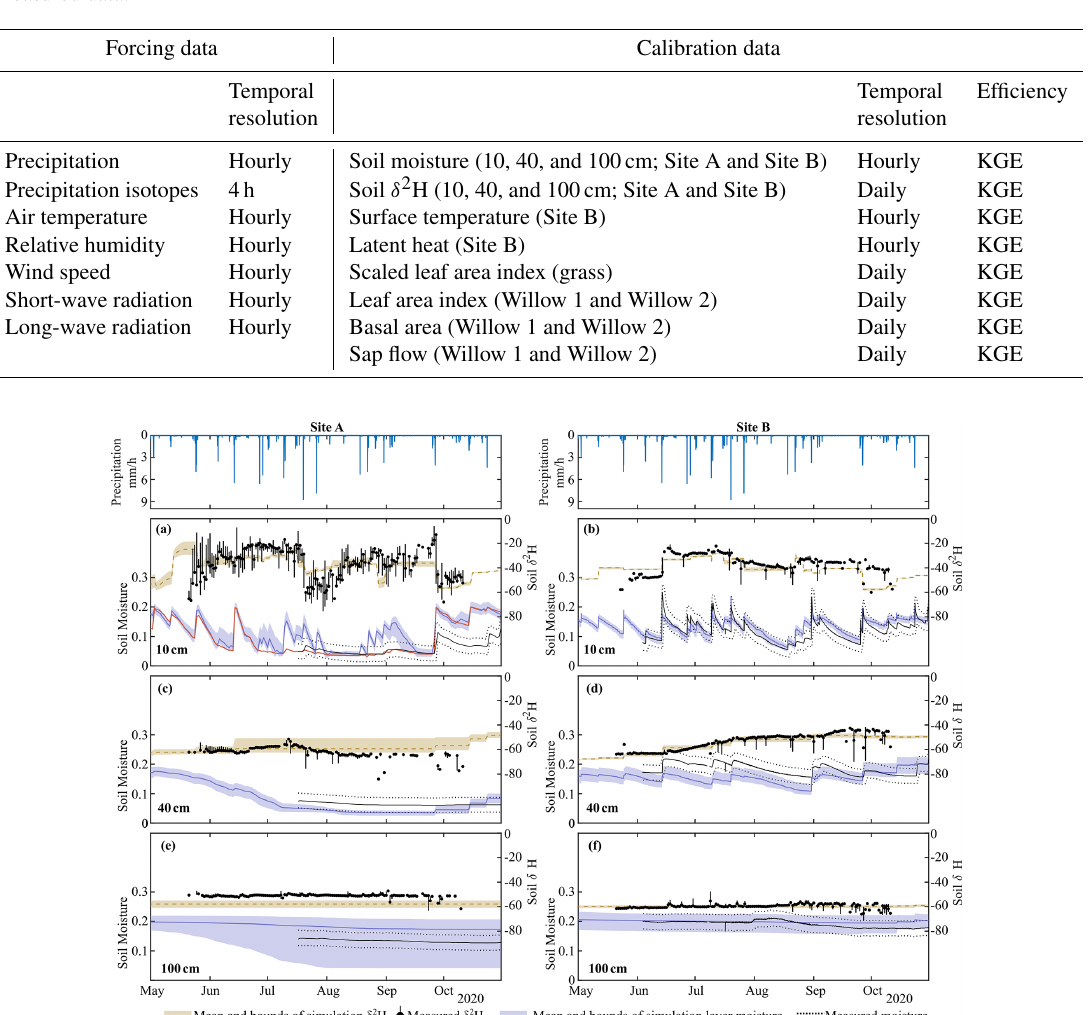
Figure 3. Simulation mean and upper and lower bounds of soil moisture and δ 2 H at Site A at (a) 10cm, (c) 40cm, and (e) 100cm and at Site B at (b) 10cm, (d) 40cm, and (f) 100cm. The top row shows the hourly precipitation for both sites. Isotopic values (circles) are average daily measurements, with bars showing the daily range in isotopic measurements. δ 18 O simulations are shown in Fig.